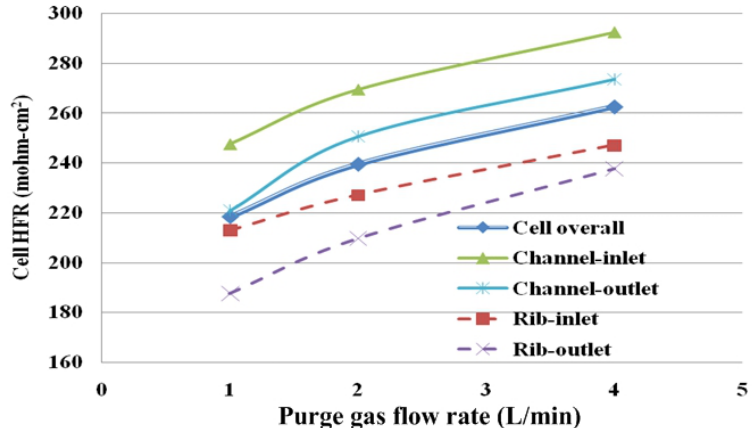
Figure 14. Values of final HFR at different local